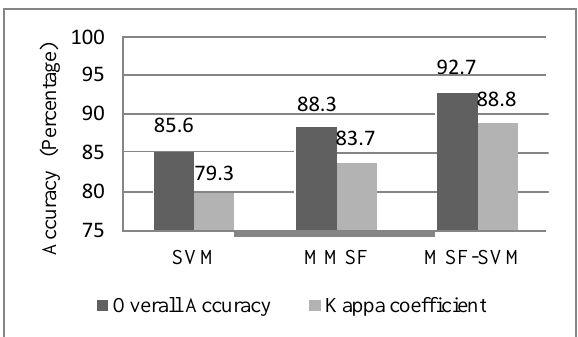
Figure 3. The global accuracies of different